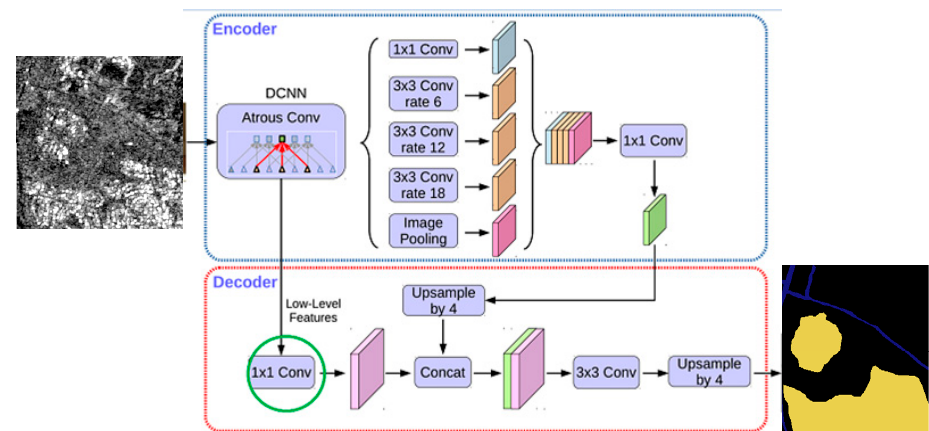
Figure 1. The structure of the Deeplabv3+ network.